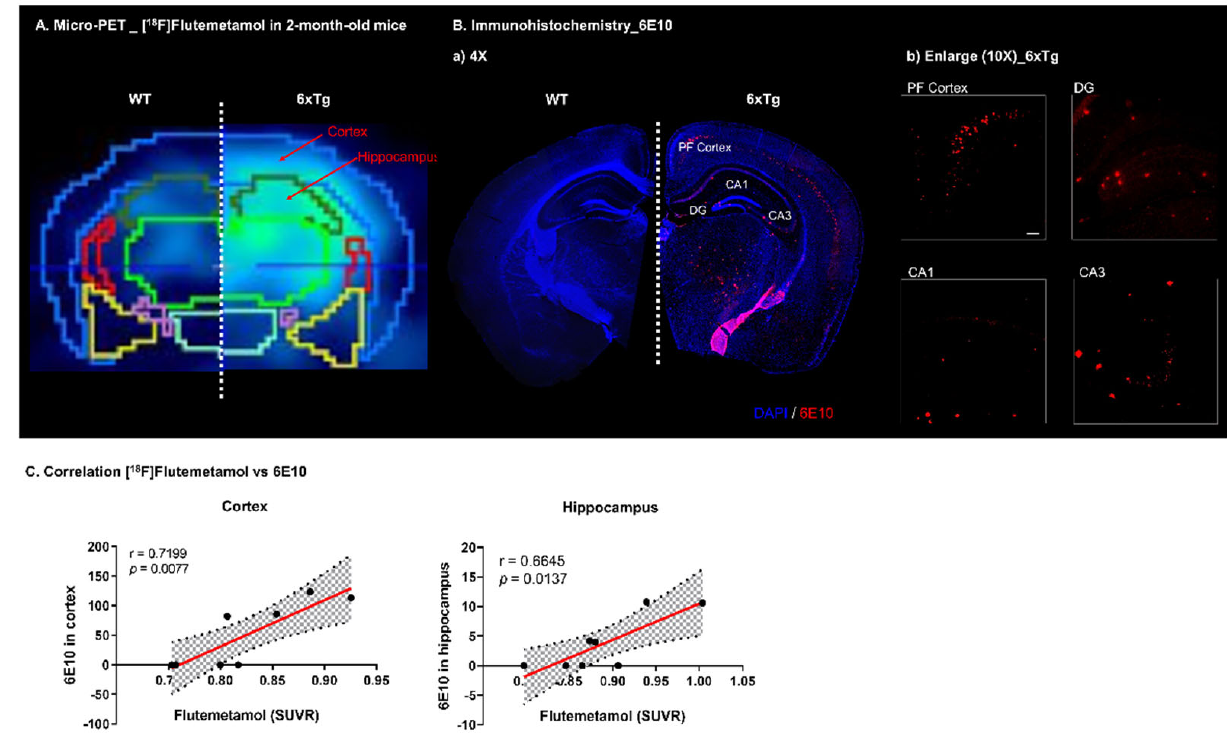
Figure 2. Representative images of [ 18 F]Flutemetamol and 6E10 immunostained image in brain. ( A ) The [ 18 F]Flutemetamol intensity of 2 ‐ month ‐ old 6 × Tg mice increases in the cortex and hippocampus compared to that in WT mice. ( B ) Brain tissues of 2 ‐ month ‐ old 6 × Tg and WT mice were im ‐ munostained with 6E10 antibody and counterstained with DAPI. Representative slices are shown for (a) WT and 6 × Tg mice brain (4 magnification) and (b) cortex (PF) and hippocampus (DG, CA1, and CA3) regions of 6 × Tg mice brain (10 magnification) (all scale bars = 100 μ m). 6E10 stained A β deposits are shown in the cortex and in the hippocampus of 6 × Tg mice brain. ( C ) The correlation between [ 18 F]Flutemetamol uptake and relative abundance of 6E10 ‐ stained β‐ amyloid deposits were assessed in the cerebral cortex and hippocampus of 6 × Tg mice by the nonparametric Spearman’s rank correlation test. Graphs show regression lines with 95% confidence intervals. [ 18 F]Flutemeta ‐ mol uptake significantly correlates with the relative abundance of 6E10 ‐ stained A β deposits both in the cerebral cortex and hippocampus of 6 × Tg mice.